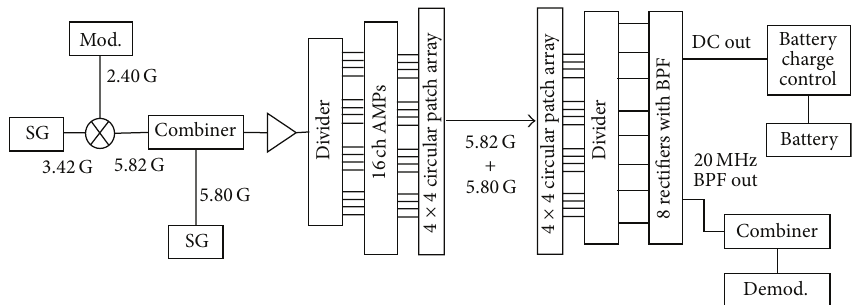
Figure 10: Block diagram of the battery charging demonstration using the WiCoPT technology.